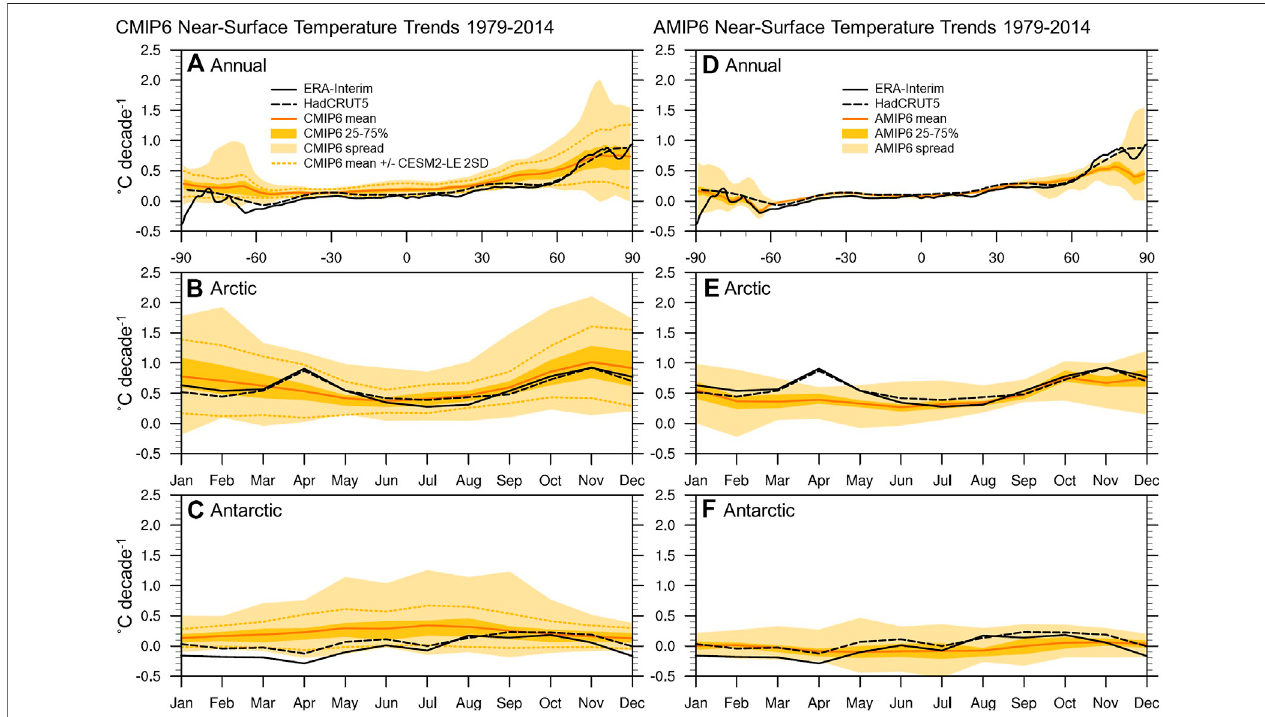
FIGURE 2 | Near-surface temperature trends ( ˚ C decade − 1 ) for 1979 – 2014 for (A,D) the annual- and zonal-mean, (B,E) the Arctic seasonal cycle, and (C,F) the Antarctic seasonal cycle in the ERA-Interim reanalysis (solid black line), HadCRUT5 observations (dashed black line), and the historical CMIP6 (A – C) and AMIP6 (D – F) multimodel means (solid orange line). The dark orange shading shows the 25th to 75th percentiles, and the light orange shading shows the full intermodel spread. The dashed orange lines (A – C) show the CMIP6 mean ± 2 standard deviations across ensemble members in the CESM2-LE.